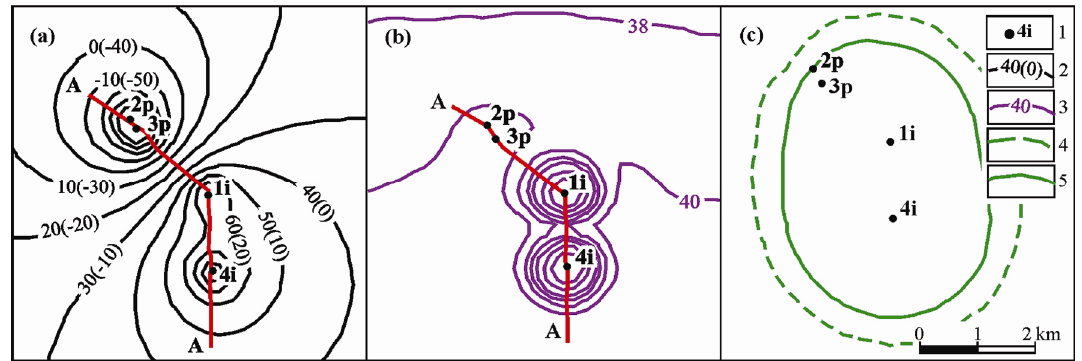
Fig. 7. Schemes of piezometric surface of fresh and real (in parentheses) water (a), isogeotherms (b) and injected material migration (c) after 50 of exploitation of KDGP wells at project capacity (model data): 1 – well and its name; 2 – isopotential line; 3 – isogeotherm, °C ; per cent of the initial concentration of injected material: 4 – 1%; 5 – 10%